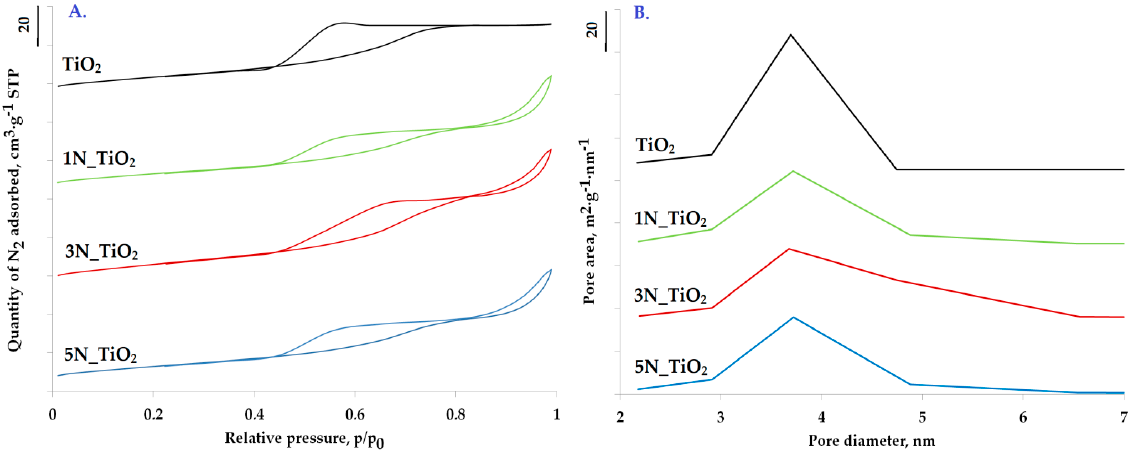
Figure 2. The N 2 adsorption/desorption isotherms ( A ) and pore size distribution ( B ) of pure and nitrogen-doped TiO 2 . The band-gap values were found to be in the range of 3.02–3.18 eV (Table 1; the